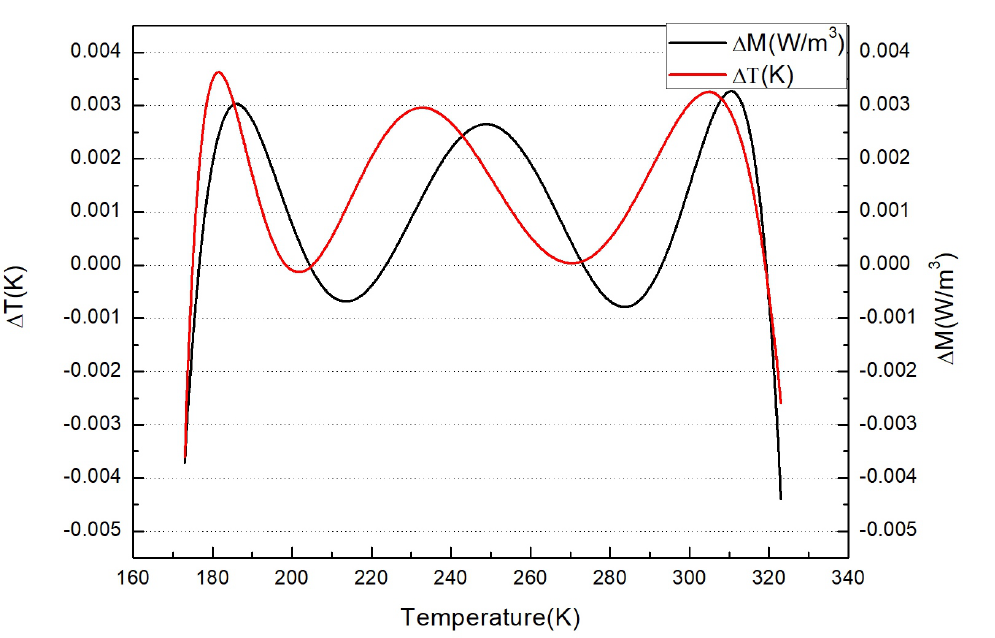
Figure 2. Fitting function and algorithm